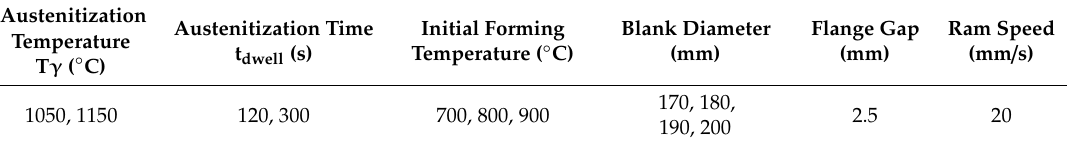
Figure 1. Temperature-time curve of thermomechanical treatment for X12Cr13, X30Cr13 and X46Cr13. Table 1. Summarization of the thermomechanical process parameters used for the deep drawing tests of X12Cr13, X30Cr13 and